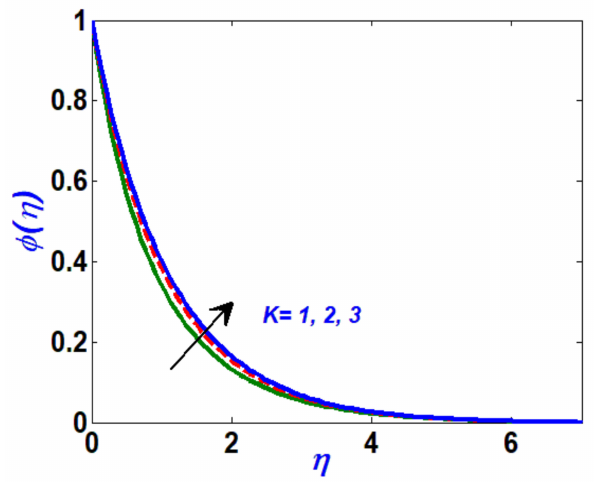
Figure 9. Concentration profile with variation in K .